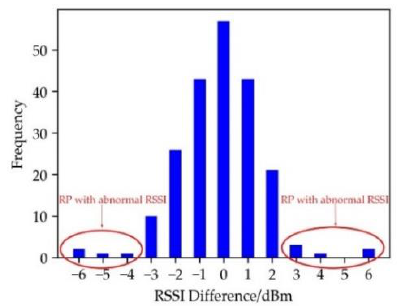
Figure 7. Histogram of RSSI di ff erence in the direction of AA (cid:48) .